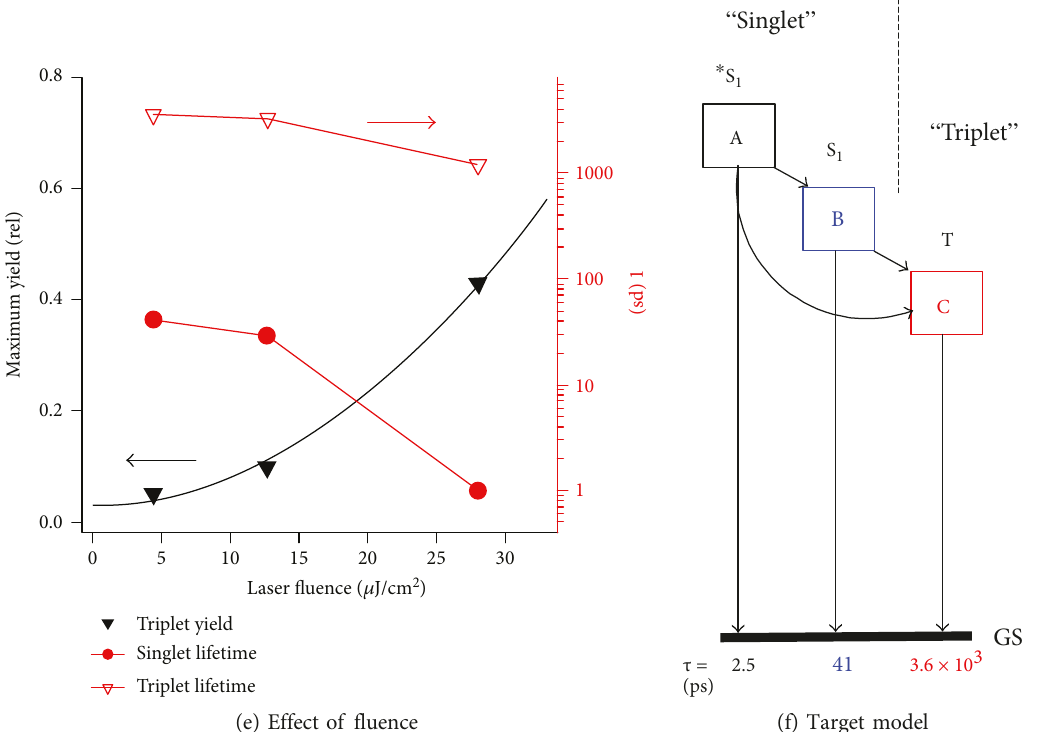
Figure 4: fs-TA data analysis of the pristine polymer fi lms at low laser fl uences (a, c) and at high laser fl uences (b, d). (a, b) Species-associated di ff erence spectra obtained from the target analysis (for (a), black is hot singlet, red is relaxed singlet, and blue is triplet; for (b), black is hot singlet, red is hot triplet, and blue is relaxed triplet). (c, d) Concentration pro fi les of the species reported in (a, b). The pulse is given in pink (in (c)) or in green (in (d)). (Note the lin-log timescale axis in (c) and (d).) (e) Laser fl uence e ff ects on the photophysical properties of the pristine polymer fi lm. Shown is the change of singlet and triplet excited state lifetimes and of the relative triplet formation e ffi ciency as function of laser fl uence for the pristine polymer fi lms. (f) Target model used for the analysis for low fl uence (for high fl uence, the three species were hot singlet, hot triplet, and relaxed